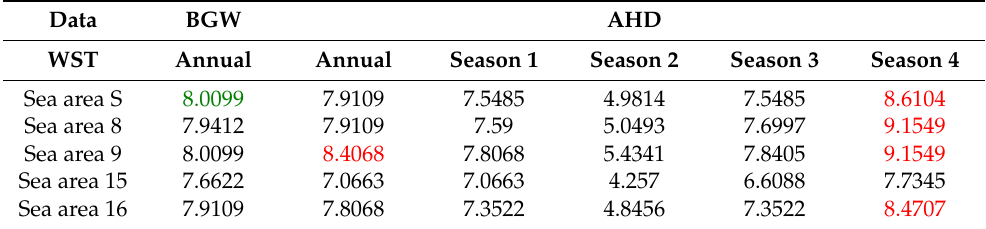
Table 12. Excessive acceleration (m/s 2 ) of C11 class container ship with modified